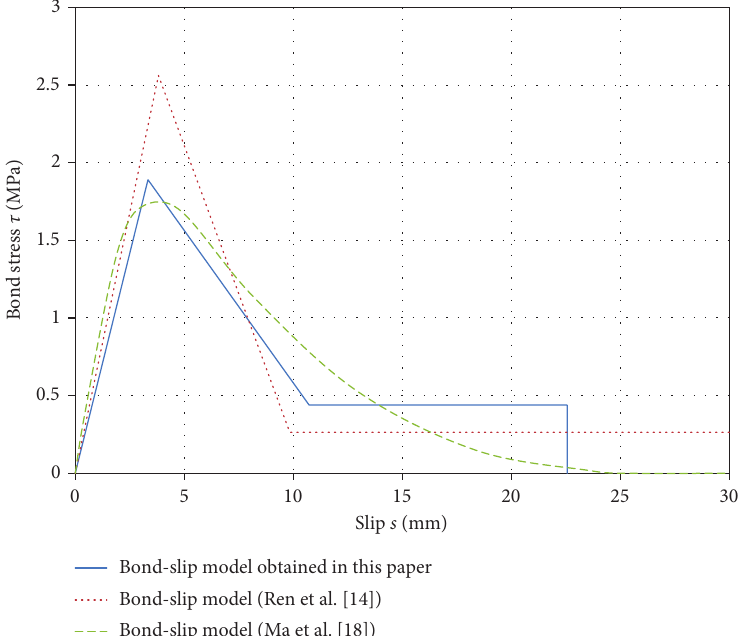
Figure 21: Comparison between the bond-slip model proposed in this paper and the bond-slip models obtained by the method of Ren et al. [14] and Ma et al.